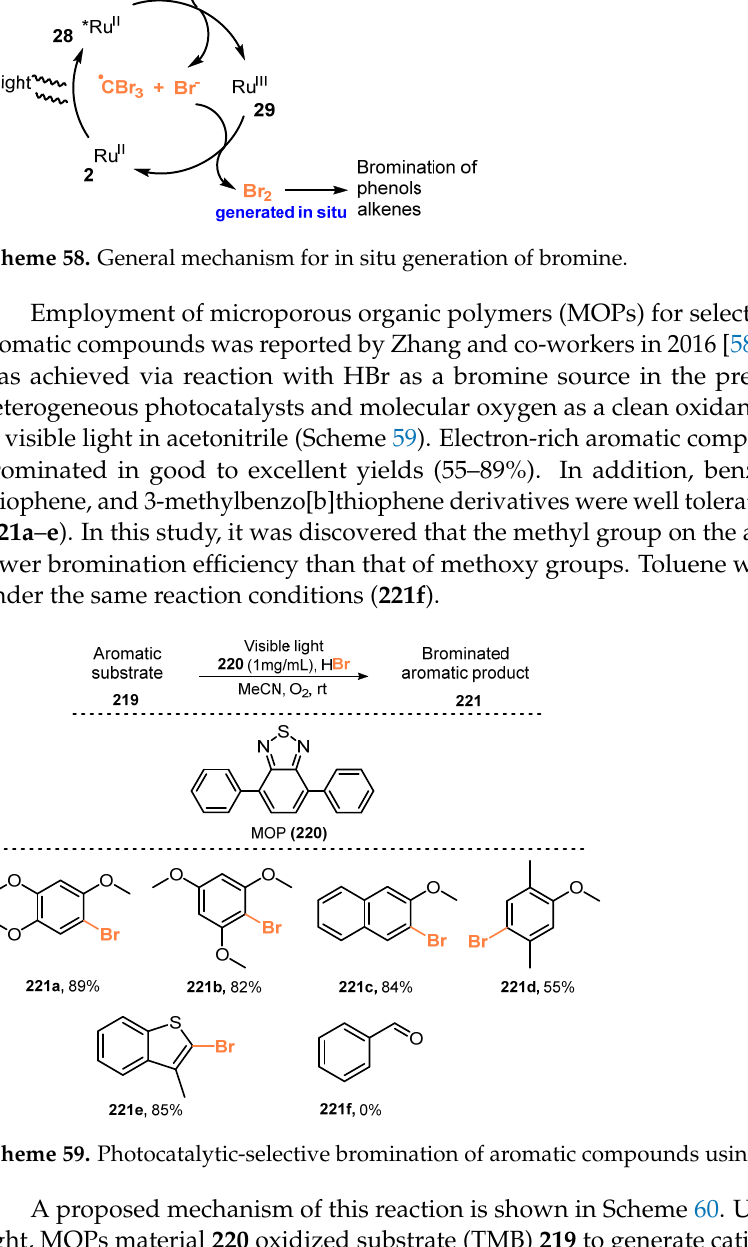
Scheme 57. Visible-light-photoredox catalysis enabled bromination of phenols.